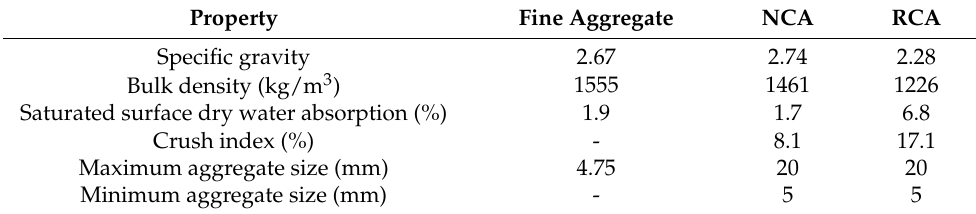
Figure 1. ( a ) Natural coarse aggregate; ( b ) Recycled coarse aggregate. Table 2. Properties of aggregates.